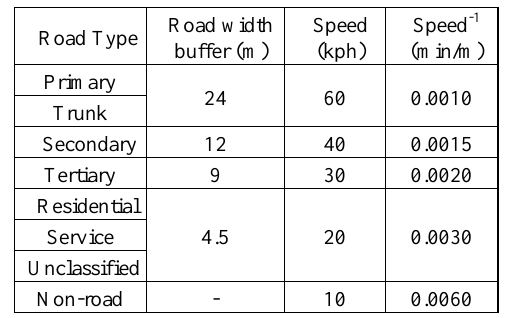
Table 3. Cost Raster